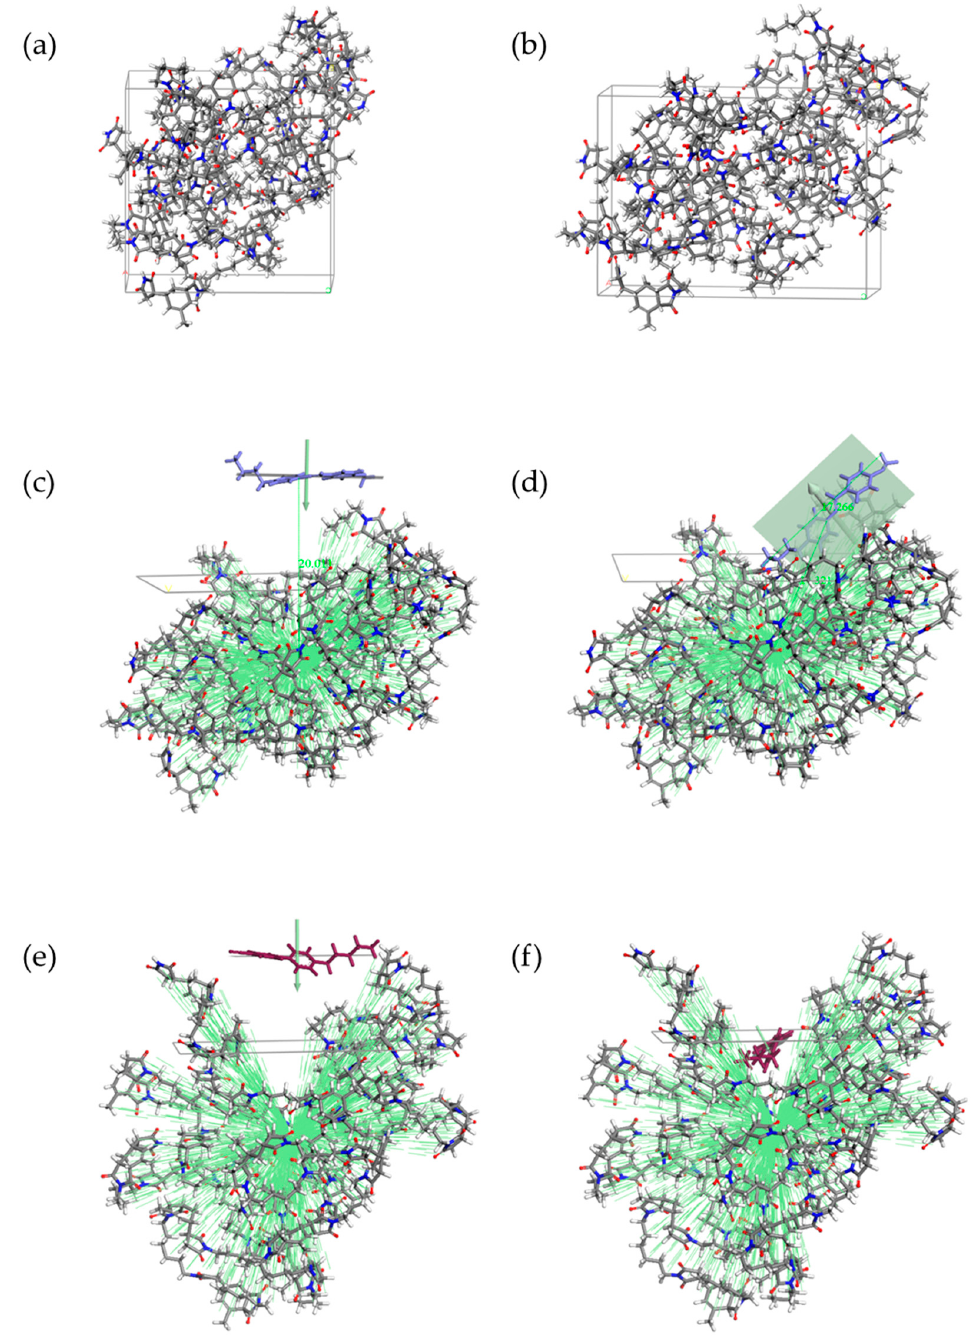
Figure 4. Snapshots of the periodic PI-HMDA cell before ( a ) and after the stretch process ( b ). The polymer layer was limited to 6 polymeric chains. The best fit plane and centroid options were used to obtain similar reference systems with adsorbed MBBA ( c ) and 5CB molecule ( e ). From the multiple outputs of the quench procedure, the system with the lowest energy was chosen for MBBA ( d ), and respectively, for 5CB ( f ).